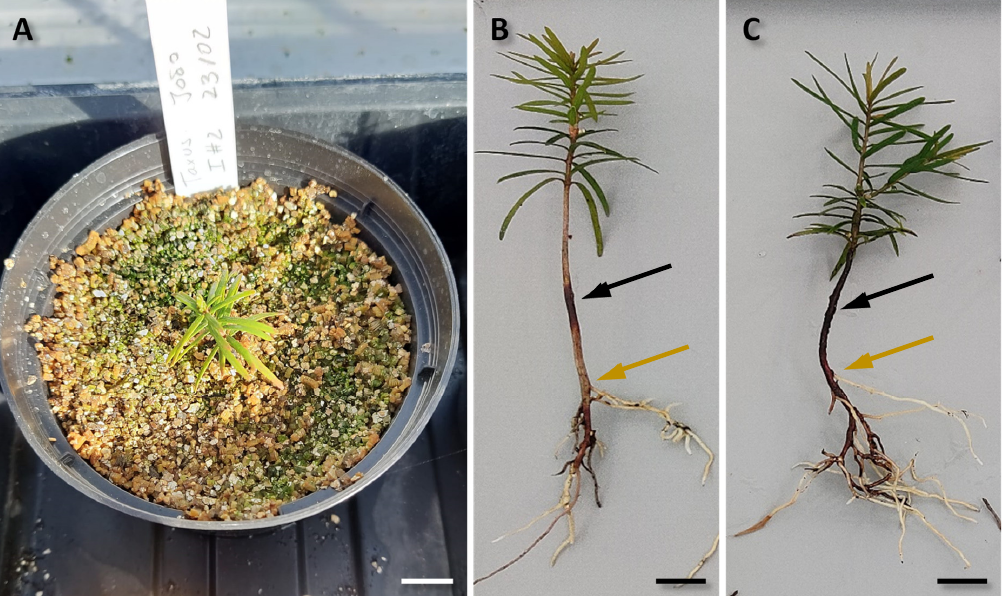
Figure 5. Seedlings inoculated by the direct inoculation ex vitro method after 2 months of inoculation. ( A ) Inoculated seedling grown in the greenhouse. ( B ) Control seedling. ( C ) Inoculated seedling; Black arrows indicate the inoculation site, while orange arrows indicate the highest protruding site of the formed roots. Bar = 1.5 cm for ( A ), and bars = 1.0 cm for ( B , C ).